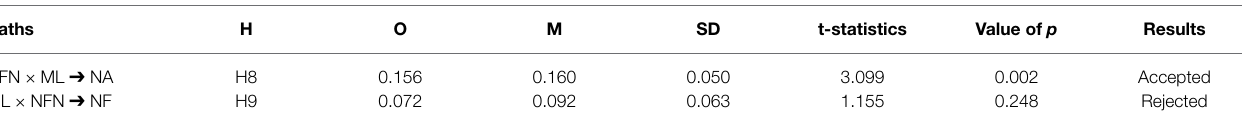
TABLE 9 | Moderating effects of the